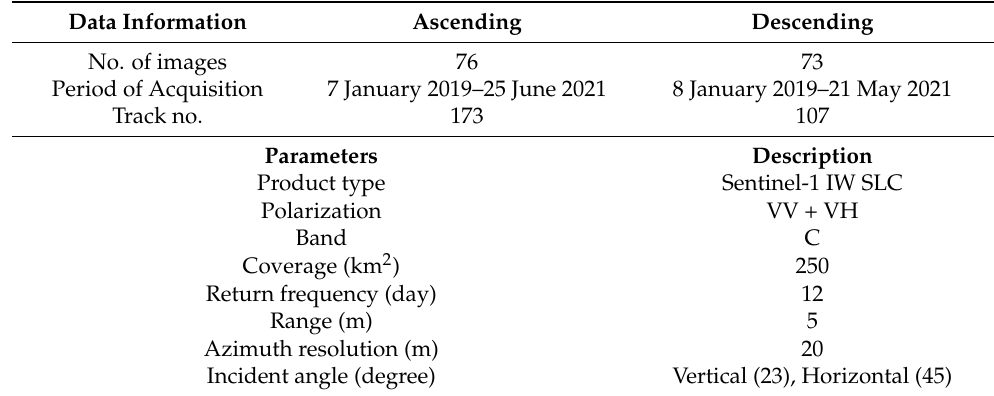
Table 1. Properties of Sentinel-1 (ascending and descending) datasets and their parameters.